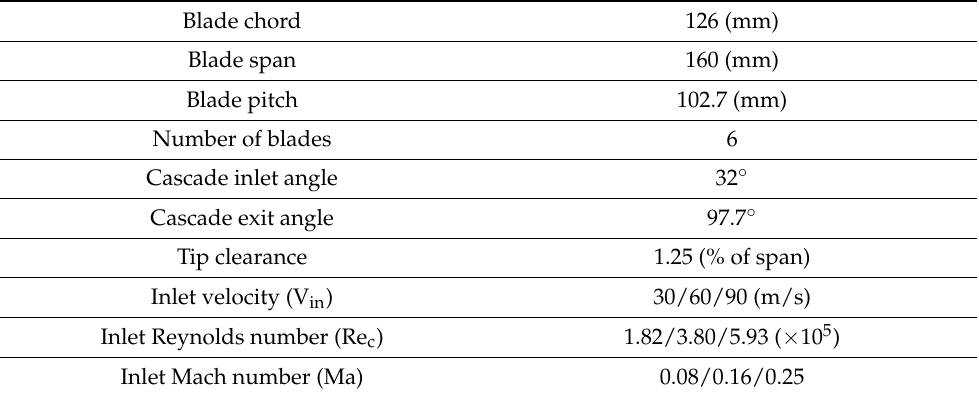
Table 1. Specifications of cascade and flow conditions.